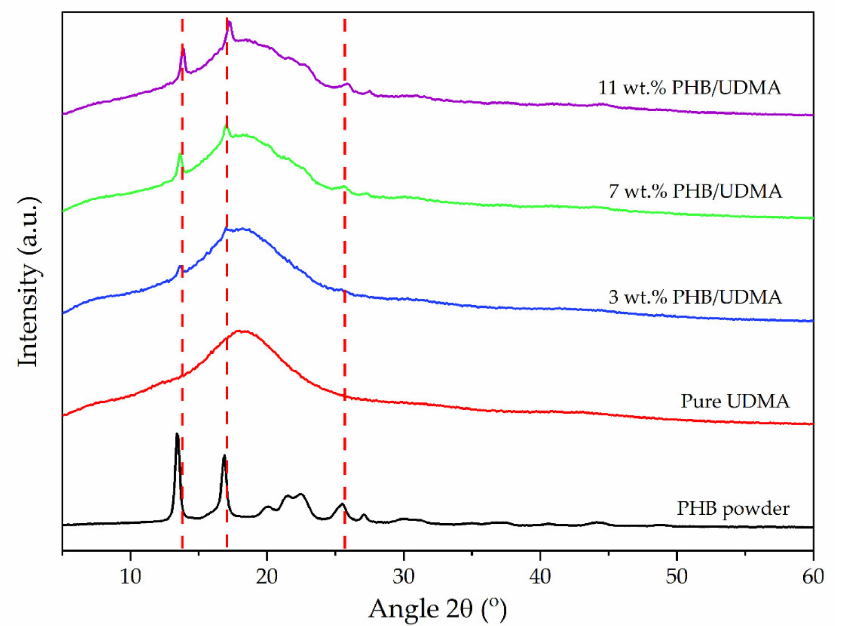
Figure 9. X-ray diffraction patterns of PHB powder, 3D printed UDMA and 3D printed PHB/UDMA.